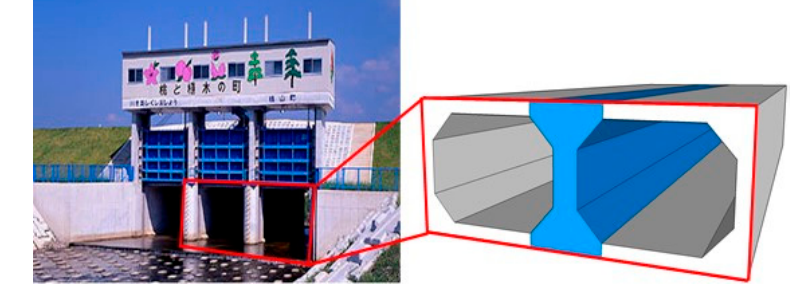
Figure 1. Sluice.